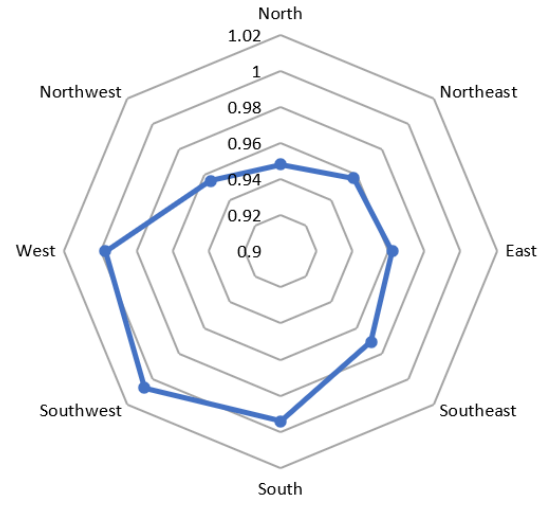
Table 2. Results of ANOVA. Left of diagonal: p -Values (in italics). Right of diagonal: Differences of Radar Drought Index depending on aspect (in bold). Significance levels: * ( p ≤ 0.05), ** ( p ≤ 0.01), *** ( p ≤ 0.001).